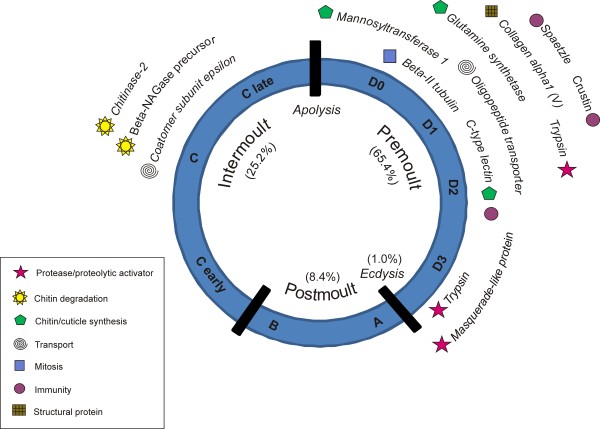
The moult cycle of Euphausia superba showing the moult stage (stages A to D3) and moult phase (pre-, inter- and post-moult). The proportional length of time spent in each phase of the moult cycle is shown in brackets. A selection of genes with proposed functions is shown adjacent to the moult stage where they were up regulated more than two fold relative to the C early control.